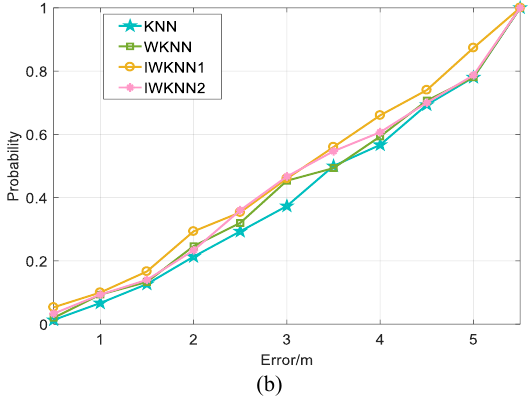
Figure 10. CDF plots of error for the compared algorithms: (a) Positioning results when using OPPO smartphone; (b) Positioning results when using MEIZU smartphone.